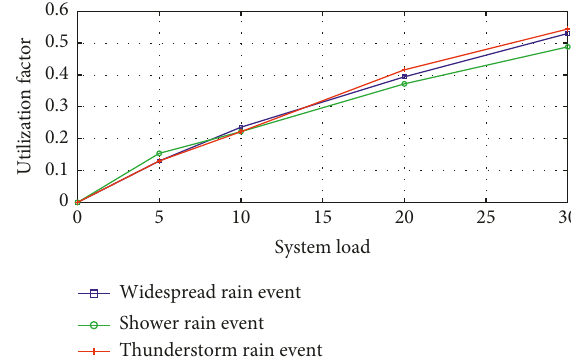
Figure 11: Comparison of throughput.